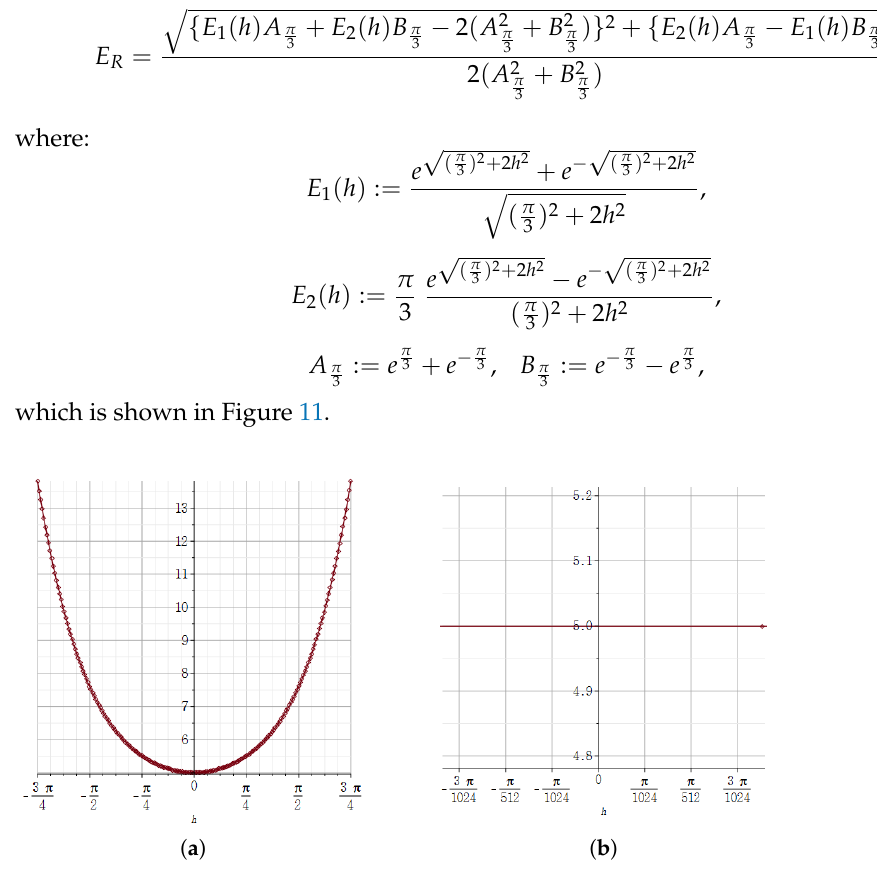
Figure 11. ( a ) The result of expressing the value of the relative error of the quaternion ( j , k ) -step derivative of sin z at z 0 on the vertical axis according to the size of the horizontal axis h using the Maple plot. ( b ) In the graph of ( a ), the result of zooming in about h near zero. It confirms that the quaternion ( j , k ) -step derivative of sin z has a relative error approximated to the minimum value for h near